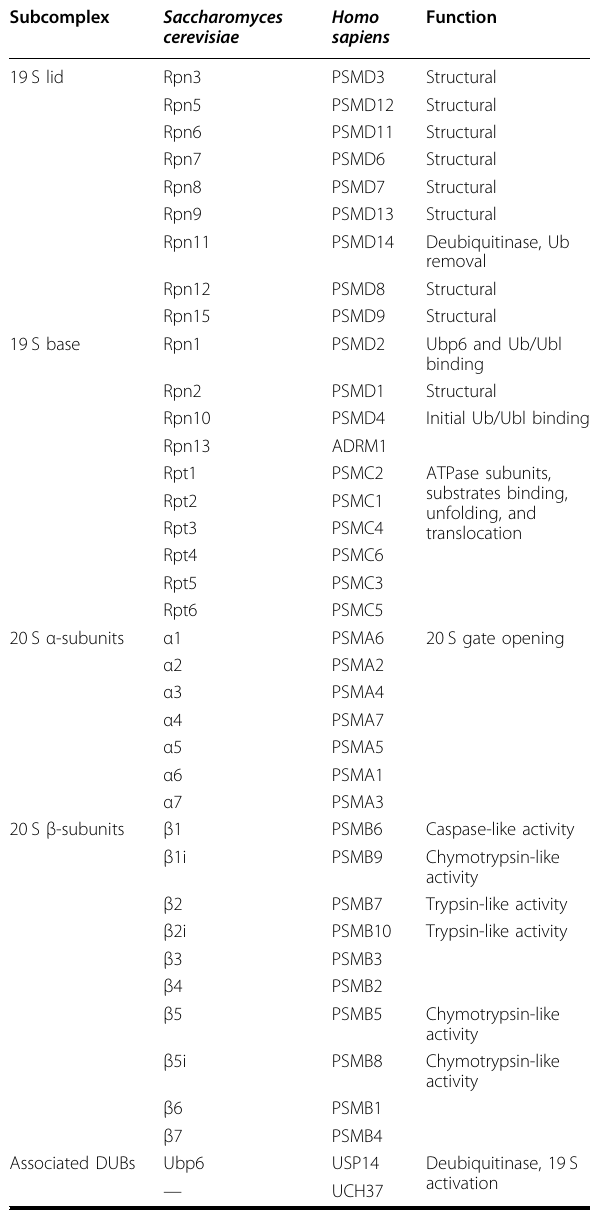
Table 1 Proteasome subunits names and function.